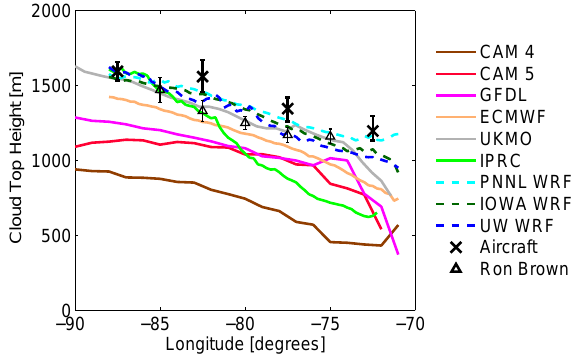
Figure 4. Model-mean cloud-top height along 20 ◦ S compared with mean cloud top measured using cloud radar from C-130 flights (Bretherton et al., 2010). Mean observations of R/V Ron Brown from 2001 to 2008 (de Szoeke et al., 2012) are plotted as triangles with bars as standard deviation.